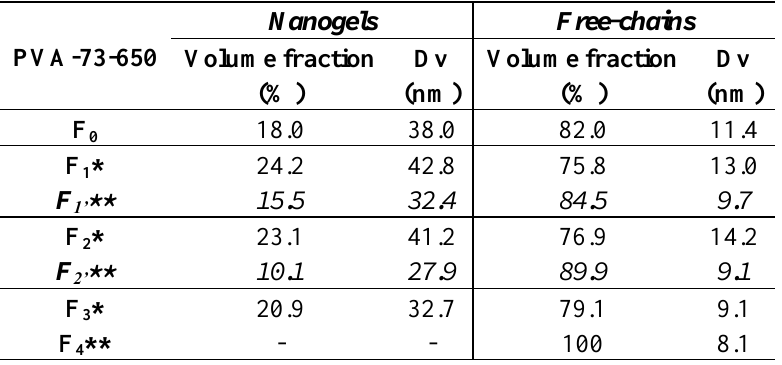
Table 2. Volume fraction and size average (Dv) of nanogels and “free chains” of different PVA-73-650 fractions at a concentration of a 1 wt%.